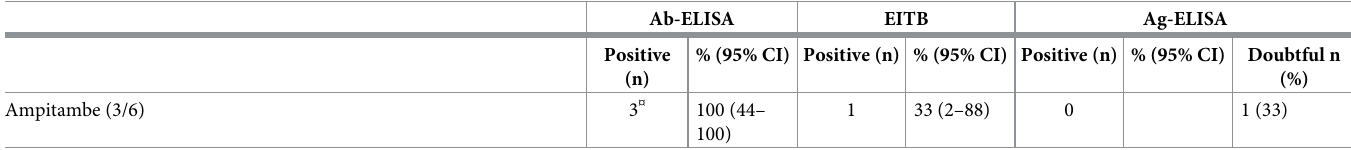
Ab-ELISA: LLGP antigens-based enzyme-linked immunosorbent assay. EITB: Enzyme-linked Immuno-electroTransfer Blot detecting specific antibodies (IgG) against T . solium cysticercus glycoproteins (GP39/42-GP24-GP21-GP18-GP14/ 13 kiloDaltons, LLGP antigens) [44]. Ag-ELISA: B158/B60 monoclonal antibodies-based enzyme-linked immunosorbent assay. An Ag-index less than 0.8 was classified as negative result, an Ag-index greater than or equal to 1.3 was considered as positive and values in between classified as doubtful. n: number of villagers and participants, total and per village or detected positively by each serological test